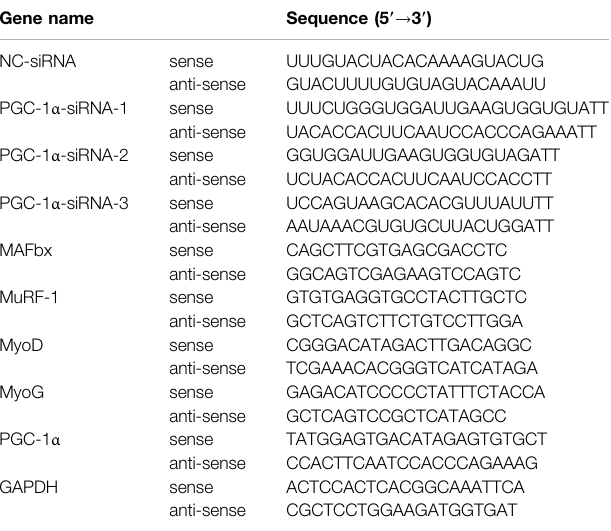
TABLE 1 | The primer sequences used for